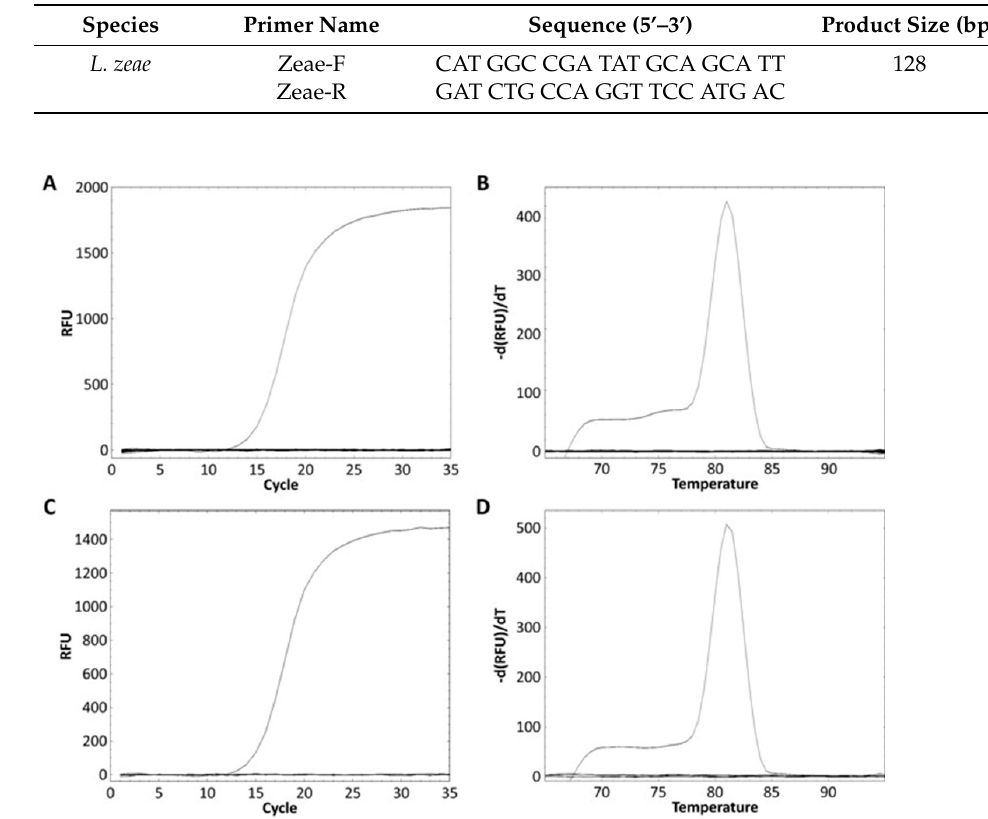
Figure 3. Real-time PCR discrimination of L. zeae from the other eight species using the primer. ( A ) Amplification curve and ( B ) melting curve obtained from a pure culture. ( C ) Amplification curve and ( D ) melting curve obtained from the mixed DNA prepared by extracting DNA from the cells of nine species and mixing 25 ng each.